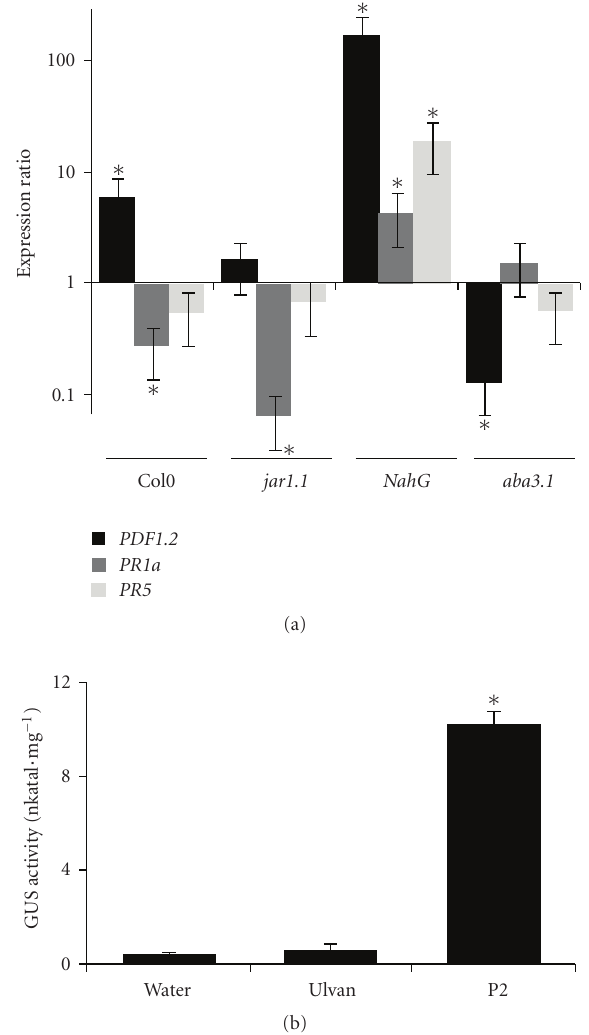
Figure 3: Expression of A. thaliana defense genes in response to ulvan. (a) RT-PCR analysis of PDF1.2 , PR1a and PR5 expres- sion in Col0, jar1.1 , NahG and aba3.1 A. thaliana 5 days after ulvan treatment (ethanol-insoluble fraction, 1mg · ml − 1 ). Data was normalized using β -Tubulin expression. Fold ratio is calculated with the corresponding control sample. Three biological replicates showed consistent results. (b) Fluorometric measures of GUS activities in leaves of transgenic Arabidopsis expressing a PR1::GUS fusion. Plants were infiltrated by water, ulvan (ethanol-insoluble fraction, 1mg · ml − 1 ), or P2 ( Phytophthora parasitica cell wall extract, 500 μ g · ml − 1 ). GUS activity was determined 1 day post infiltration and quantified using fluorescent 4-methylumbelliferone as substrate. Mean and standard errors were calculated from three independent replicates. Specific activity is expressed as nkatal per mg of total proteins. Mean for each treatment was compared to the control mean using a Student’s t -test. Treatment associated to a P -value ≤ . 05 or ≤ . 01 was marked, respectively, by ∗ or ∗∗